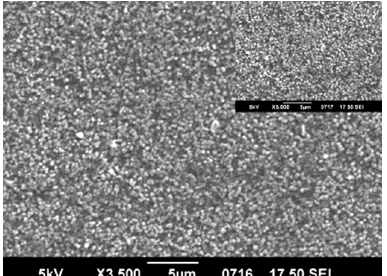
Figure 5. SEM images of the as ‐ grown vanadium oxide coating by APCVD at 550 °C for gas precursor ratio VCl 4 :H 2 O of 1:7.